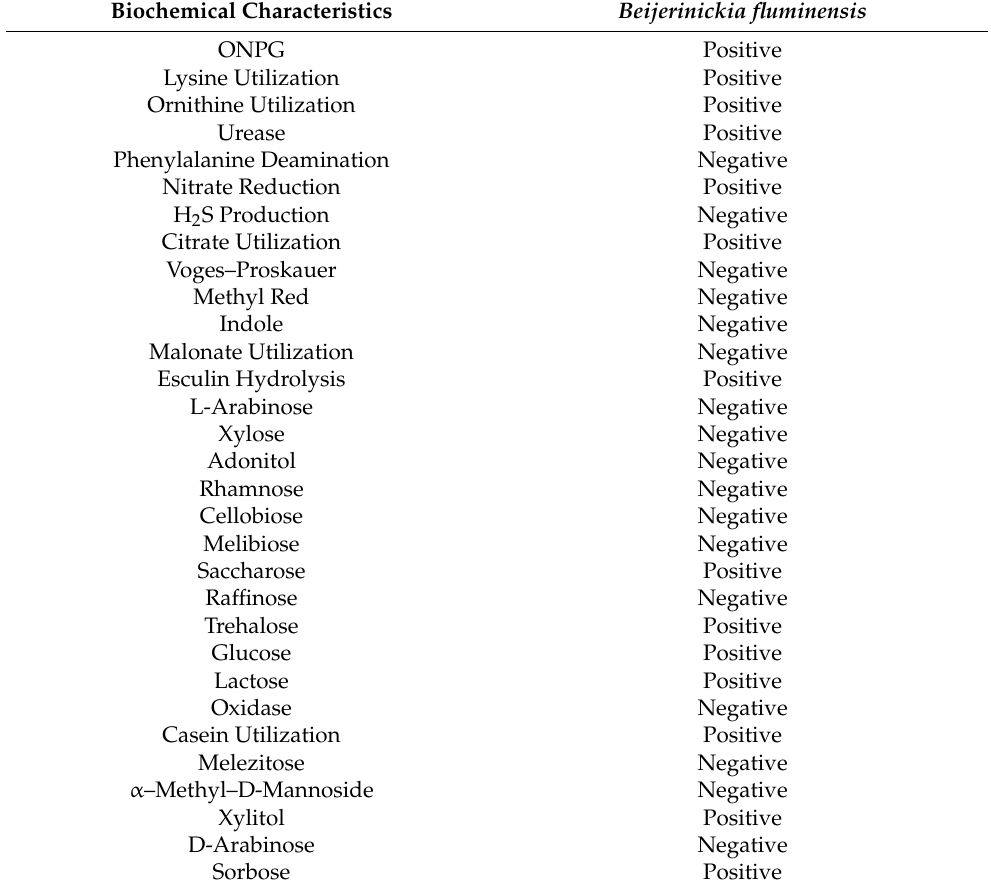
Table 2. Biochemical tests of Beijerinickia fluminensis VIT01 strain. Biochemical Characteristics